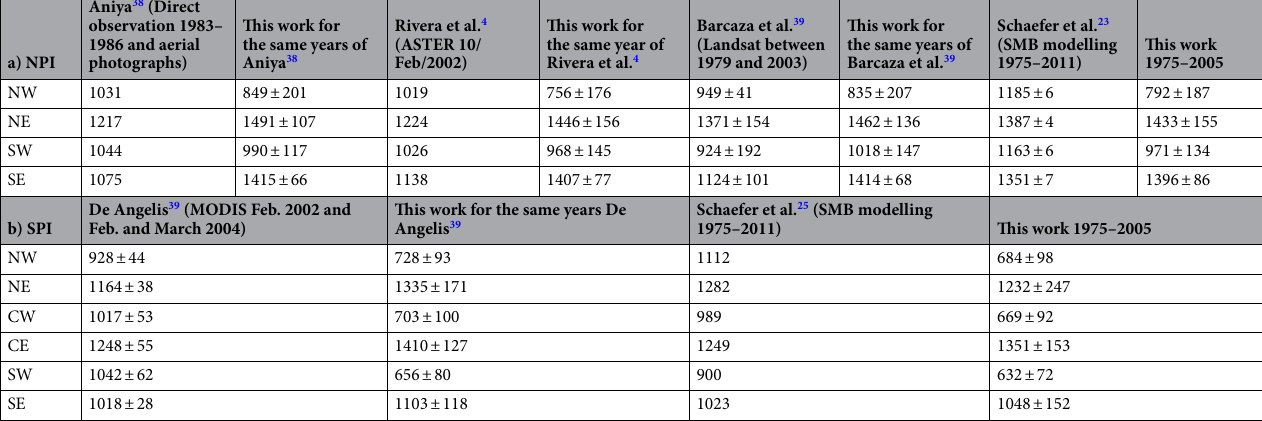
Table 1. Comparison of the ELA per sub-zone obtained in this work for the historical period with those obtained by observations of the end of summer snowline using satellite images 4,38–40 and by SMB modelling 23,25 . Previous values are the mean of several glaciers observed. Number of glaciers are variable depending availability in the references. The uncertainty range in our work is given by the sensitivity of the model to the parametrization of the cooling effects and the methods used to compute the partitioning of rain and